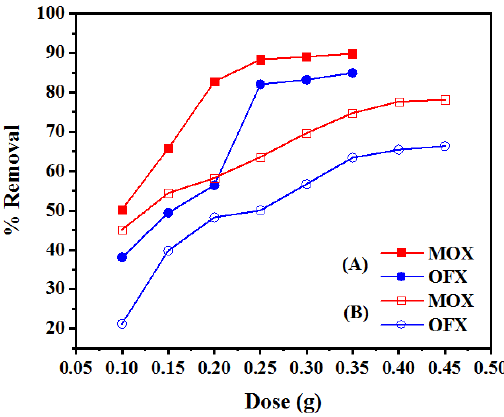
Figure 8. Effects of adsorbent amount on removal rate of MOX and OFX in single-component system onto ( A ) Met-GO/SA (at pH: 7, concentration: 20 mg/L, temperature: 35 °C, time: 140 min) and ( B ) GO/SA (at pH: 7, concentration: 20 mg/L, temperature: 35 °C, time: 200 min).